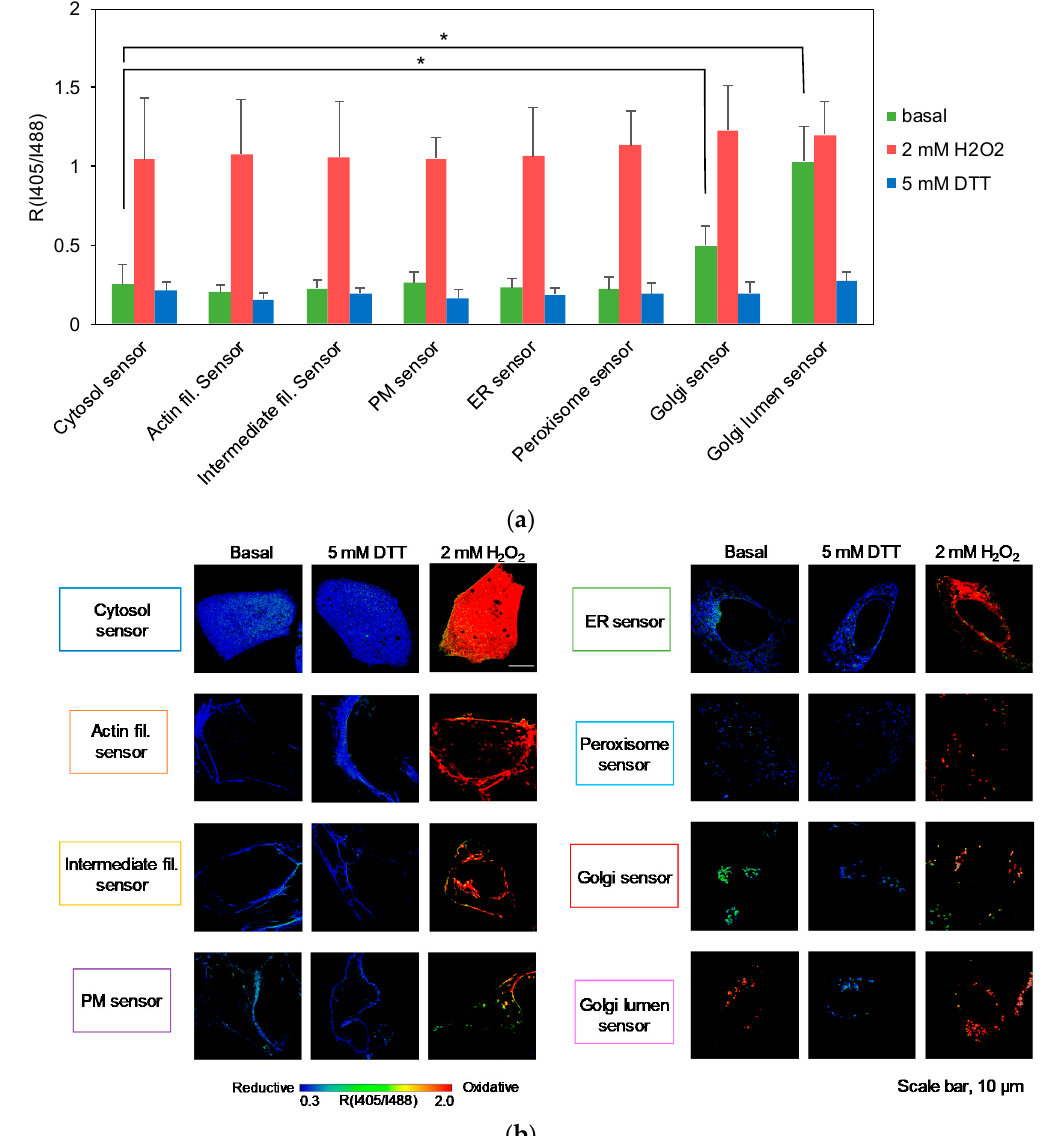
Figure 6. Membrane-targeted sensors reported overall reduced E GSSG/GSH levels in organelle-peripheral cytoplasm. Marked redox gradient across Golgi membrane was observed. ( a ) HeLa cells expressing redox sensors were subjected to ‘redox fixation’ (see Materials and Methods for the detail) and I405/I488 ratiometric imaging was performed by confocal microscopy. R I405/I488 value represents the degree of sensor oxidation. As an oxidized/reduced control, cells were treated with either 2 mM H 2 O 2 (oxidized) or 5 mM DTT (reduced) for 2 min prior to redox fixation. Data represent the average of multiple cells (n > 20) and standard deviation. Asterisks indicate significant differences assessed by student’s t-test (* p < 0.05). ( b ) Representative R I405/I488 ratiometric images are shown. Scale bars, 10 µm. The original I405 and I488 images are shown in Supplementary Data 7.